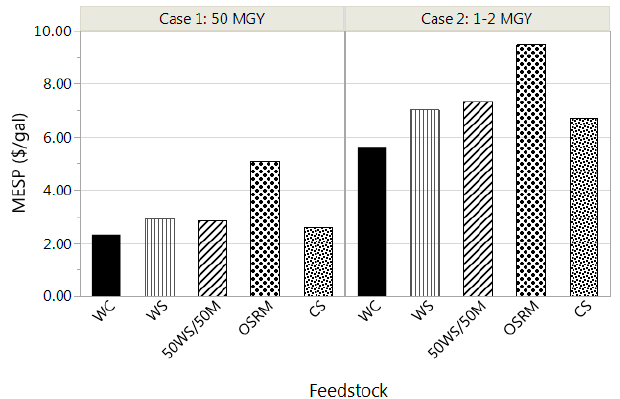
Figure 2. Minimum ethanol selling prices (MESP), for Case 1: 50 million gallons per year (MGY) facility (see Table 5; Table 1 for feedstock cost with transportation distance of 60 km) and Case 2: 1 to 2 MGY (see Table 6; Table 1 for feedstock cost with transportation distance of 20 km) for various feedstocks with gasification at 850 ° C. WC: wood chips; WS: wheat straw; 50WS/50M: 50% wheat straw & 50% manure; OSRM: OSR meal; CS: corn stover.